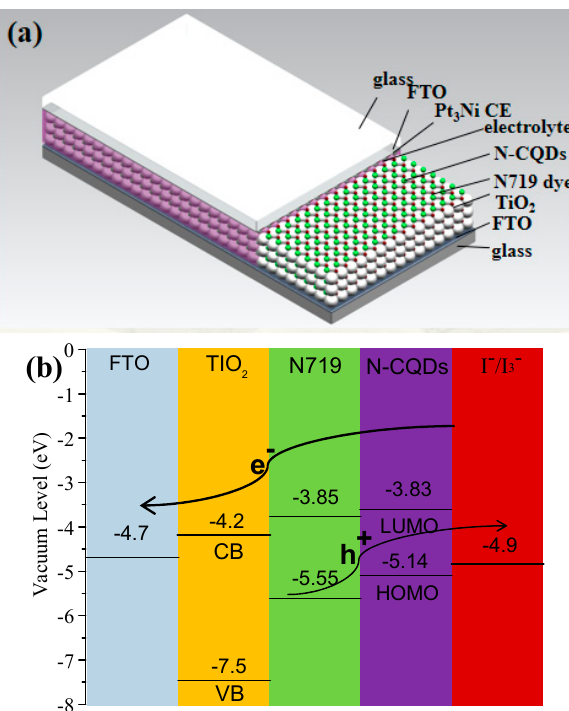
Figure 5. ( a ) The schematic diagram of the co-sensitized solar cells and ( b ) energy level distribution and charge transfer processes at the interface.